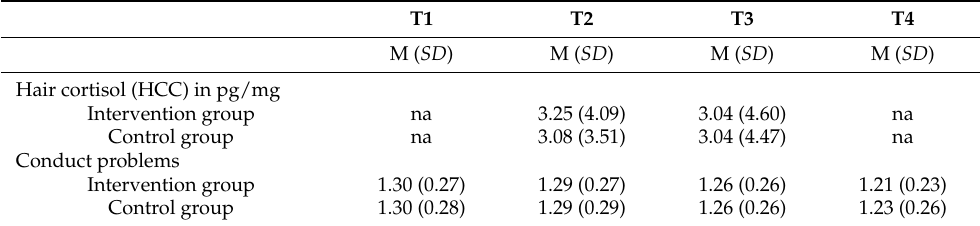
Table 2. Means And Standard deviation of the outcome